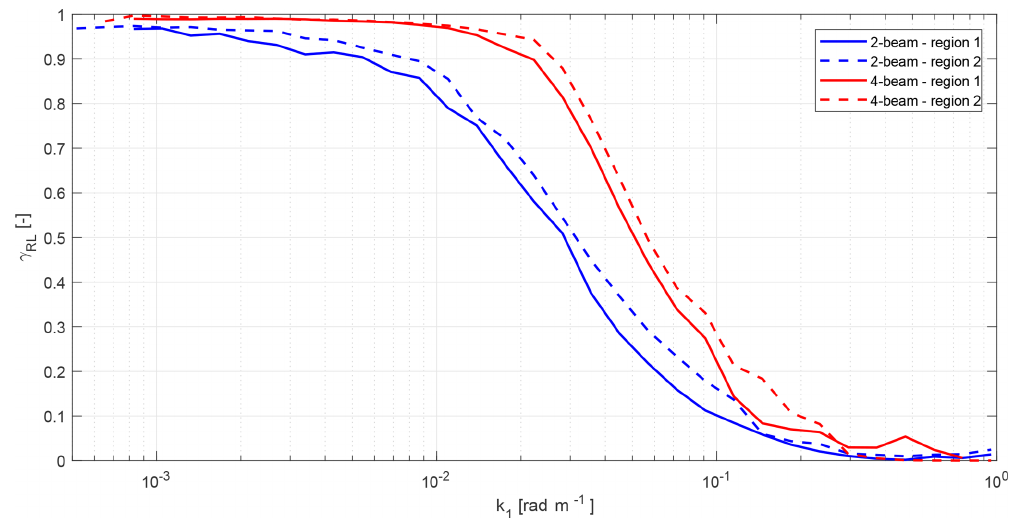
Figure 11. Comparison of the measured coherence of the two- and four-beam lidars for regions 1 and